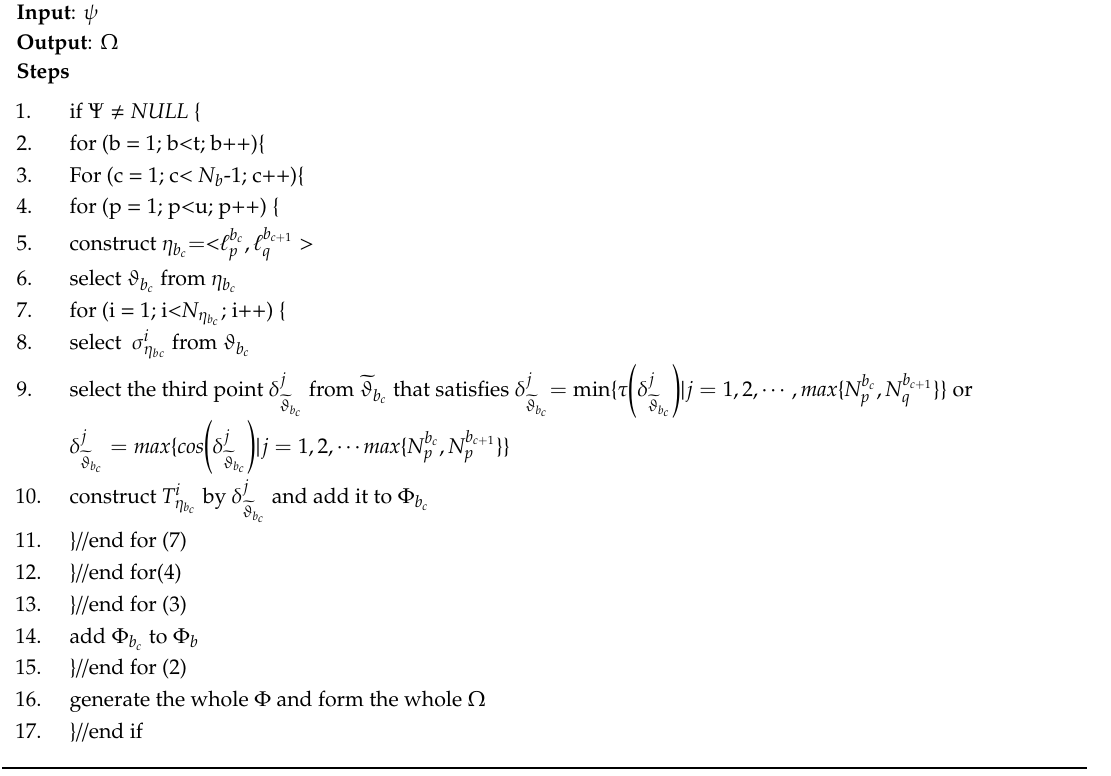
Algorithm 2 The Steps of the LC-TIN Algorithm